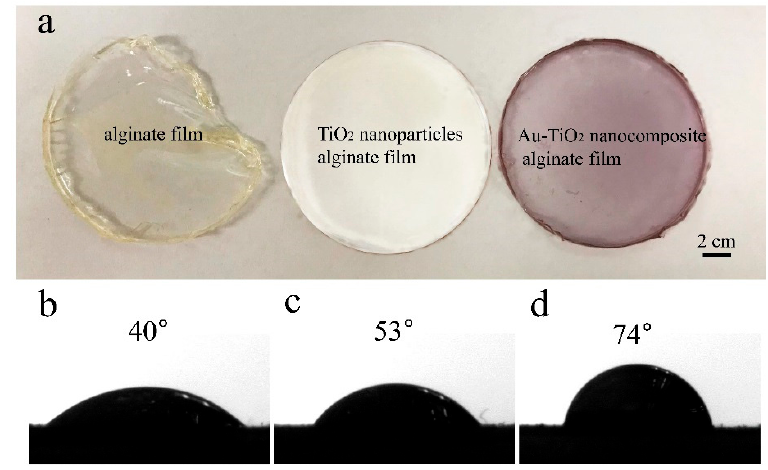
Figure 3. ( a ) Photos of different films after drying process; Contact angles: ( b ) Alginate film, ( c ) TiO 2 NPs alginate film, and ( d ) Au-TiO 2 nanocomposite alginate film.